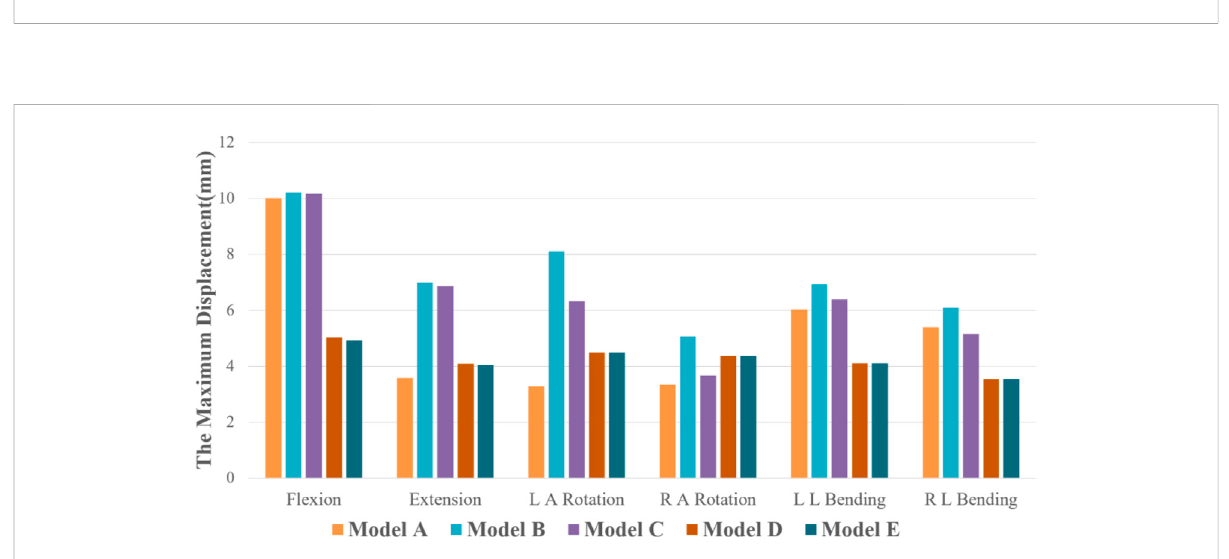
FIGURE 5 The maximum displacement of fi ve fi nite element models under six motion